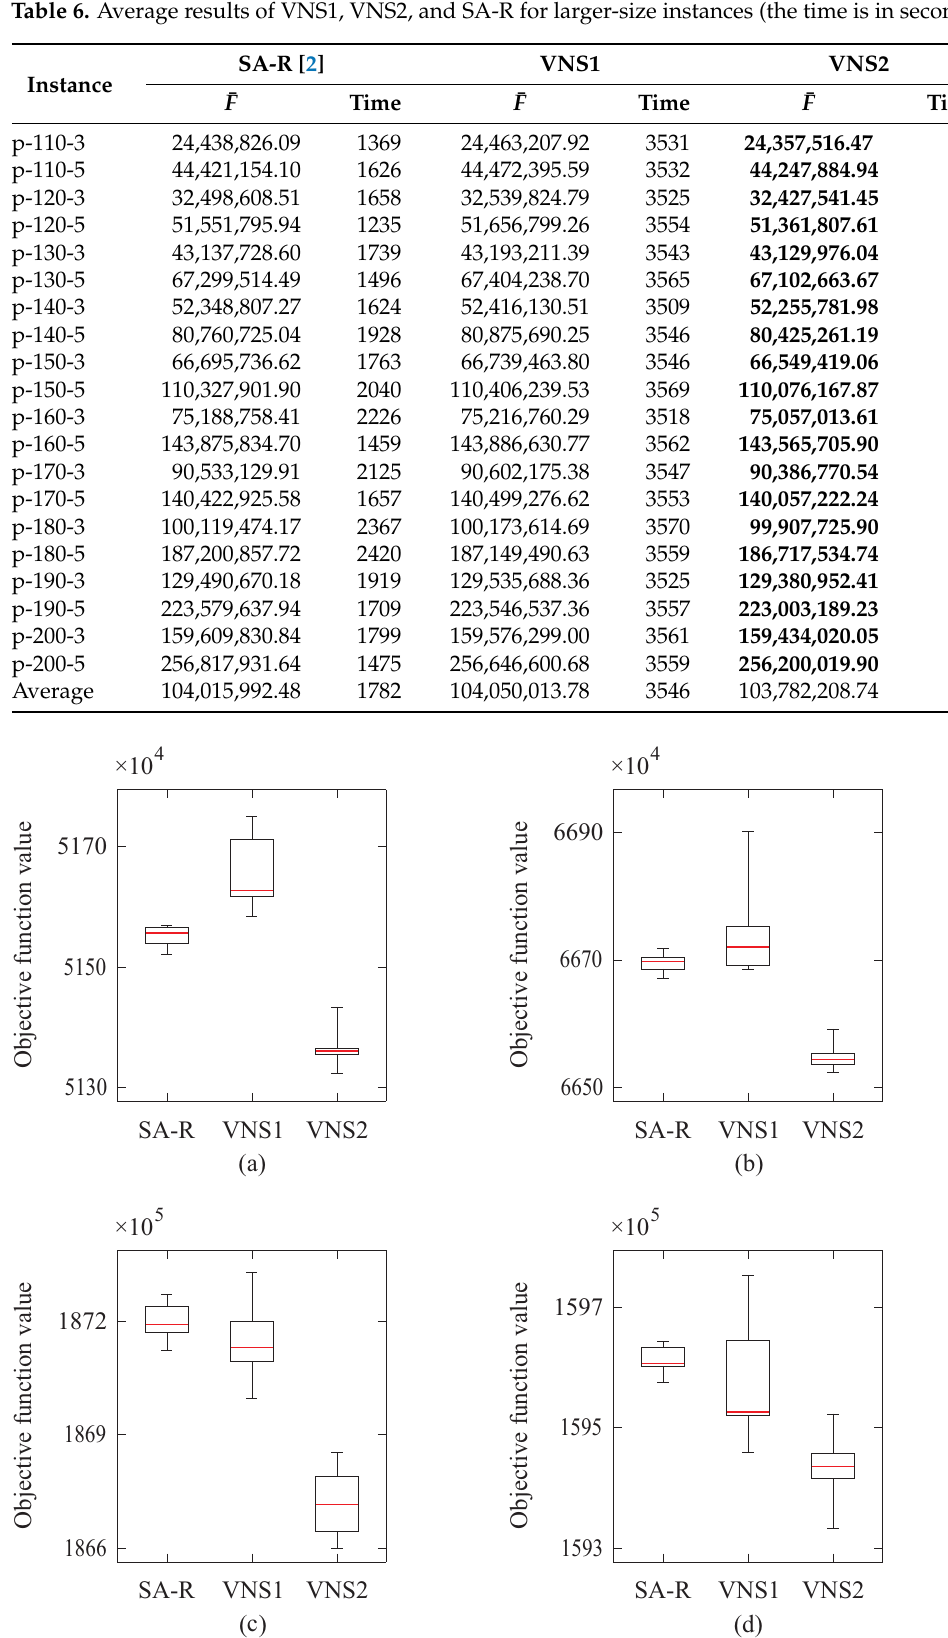
Figure 10. Objective function values achieved by SA-R, VNS1, and VNS2 on four DSRFLP instances with n > 100: ( a ) p-120-5 ; ( b ) p-150-3 ; ( c ) p-180-5 ; and ( d ) p-200-3